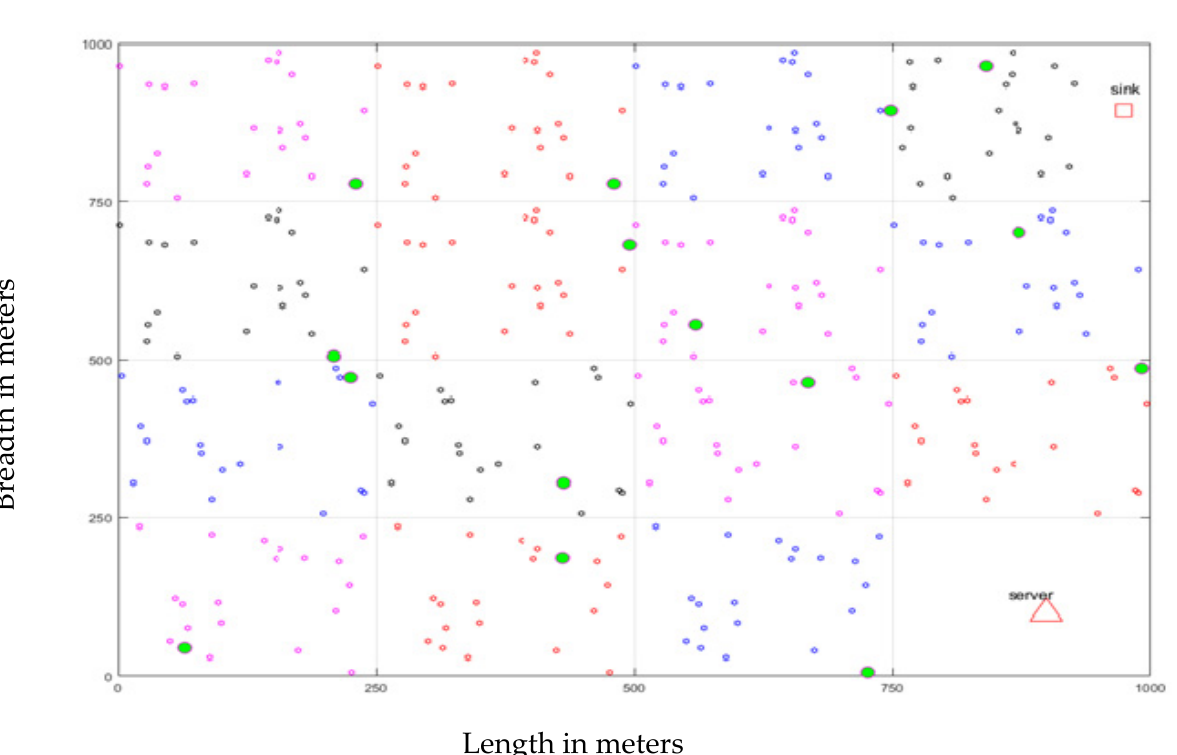
Figure 7. Election of Grid Organizer in Each Grid.